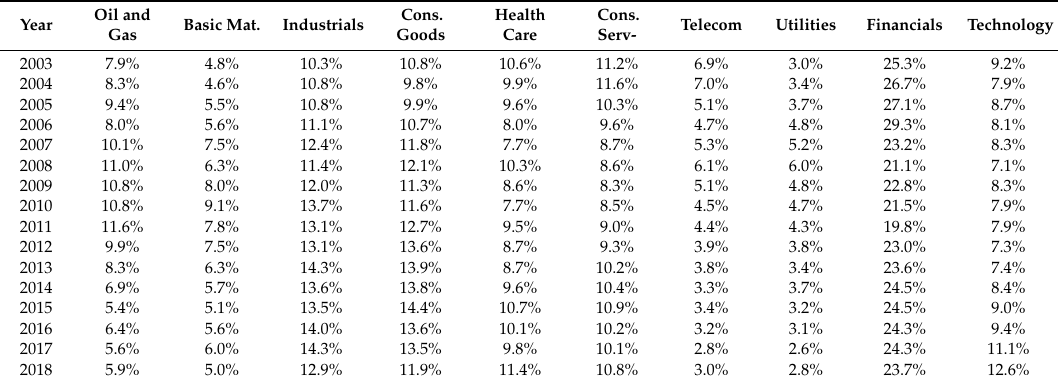
Table 4. The weights of ICB industries in the Government Pension Fund Global over time. Source: Norges Bank Investment Management